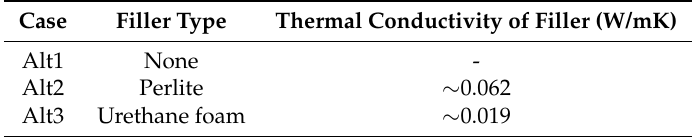
Table 1. Three types of fillers used in the internal air gap of the RFIRHP and their thermal conductivity. Case